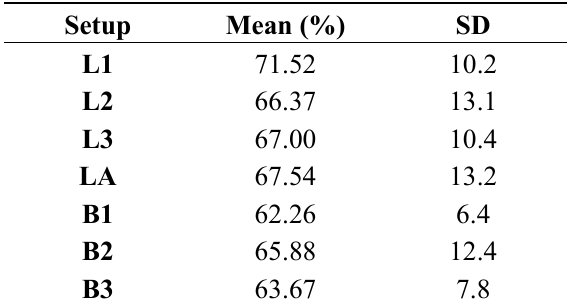
Table 3. Mean percentage and standard deviation (SD) of ghost points detected using a distance-based filter. The standard configuration was used for the filter: kernel size = 3 × 3, distance threshold = 2 cm, and allocation threshold = 50%.